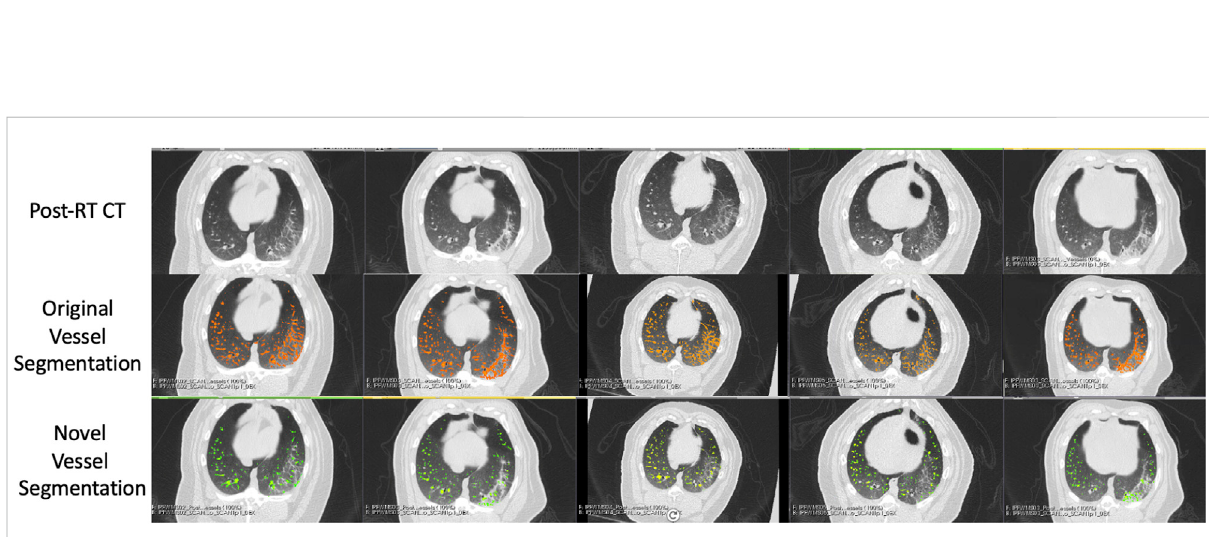
FIGURE 6 Segmentation results in the fi ve Group (A) swine. Each column represents a subject where the top row shows the post-RT CT image in an axial slice showing the post-RT radiographic change. The middle row shows the original vessel segmentation overlayed on the CT in red which in all subjects classi fi eddamaged regions of thelungas vessel. The bottom row shows theresult ofthenovel vessel segmentationwork fl owoverlayed on the CT in green. In all subjects, the apparent quality of the vessel segmentation improves in the regions of radiographic change as indicated by thereduction inlarge connected regions being identi fi ed.The resulting segmentationappears to alignwith vessels that can beobserved intheCT in both irradiated and non-irradiated